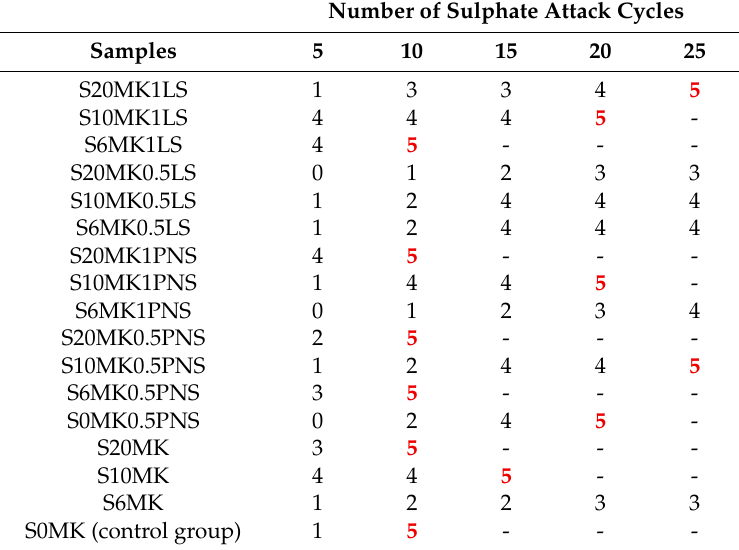
Table 6. Visual alteration after 5, 10, 15, 20, and 25 magnesium sulphate attack cycles, showing the numerical values of the damage scale